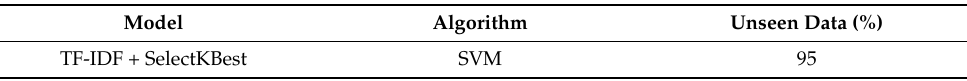
Table 6. Classification results for TF-IDF feature extraction with handcrafted features when using 10-fold cross validation and on unseen data